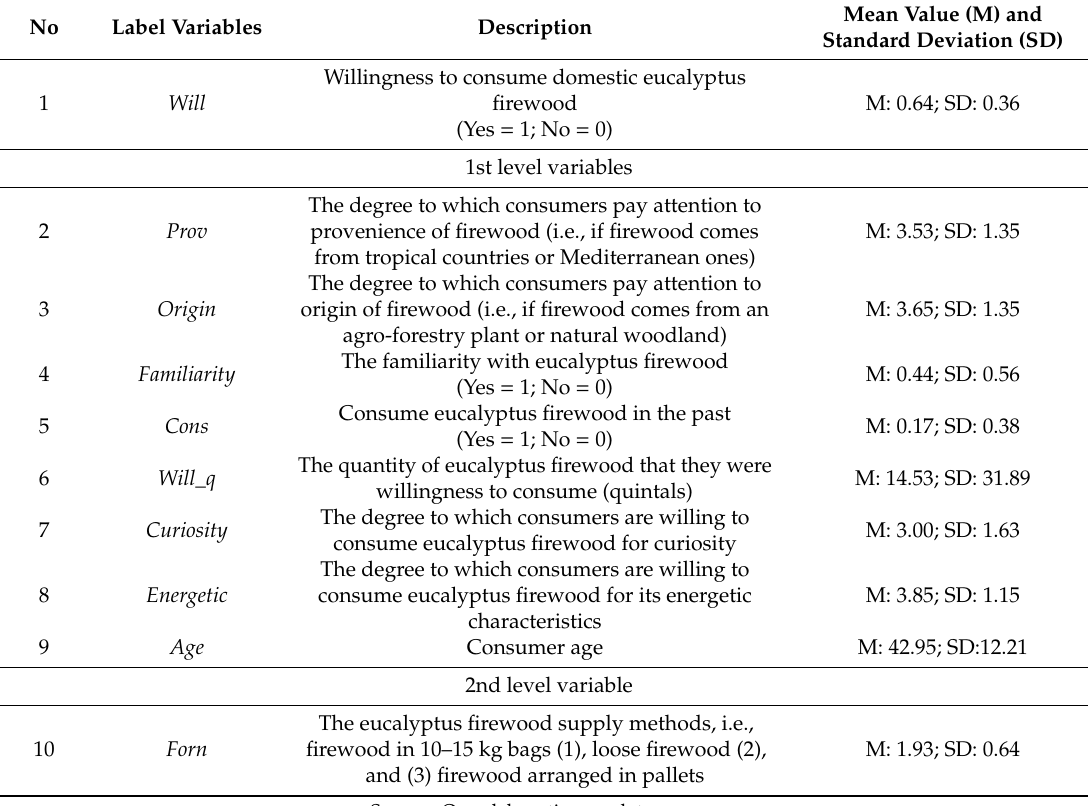
Table 5. Variables used in the full multilevel logistic regression model ( n = 282).